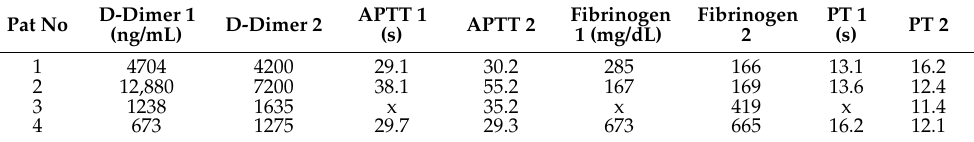
Table 2. Coagulation laboratory parameters on admission and onset of the bleeding.